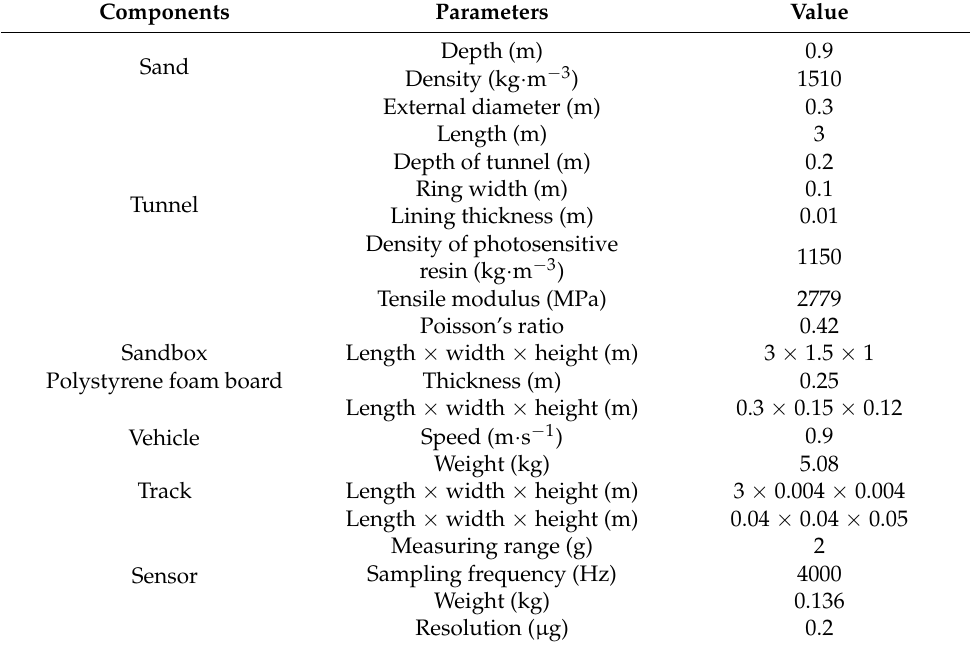
Figure 4. The model and the test system in the laboratory. Table 1. Key physical parameters of the model.